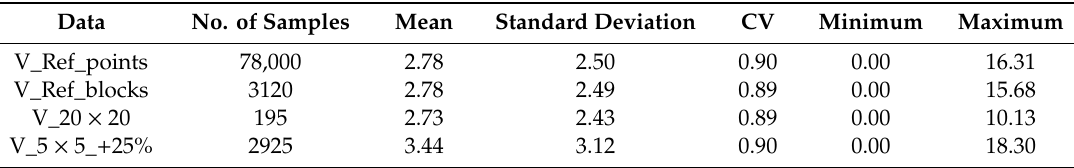
Table 1. Main statistics of the original reference dataset and the uncertainty dataset used in this work.